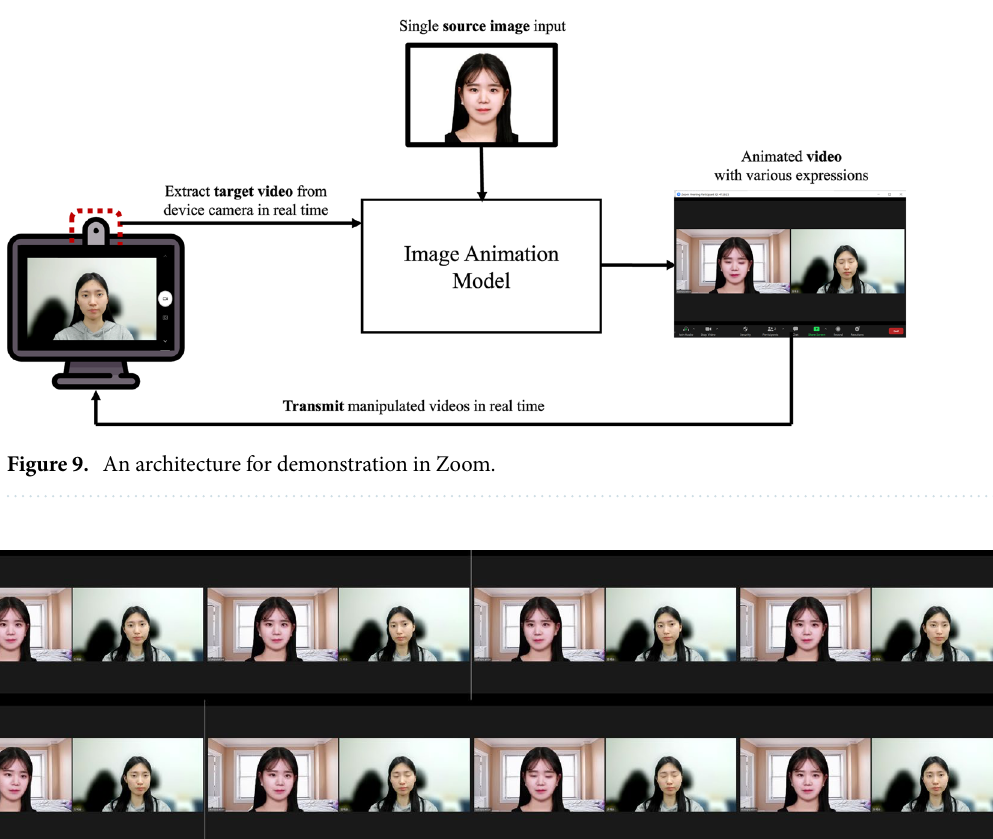
Figure 8. Differences between the two models when the facial expression changes.